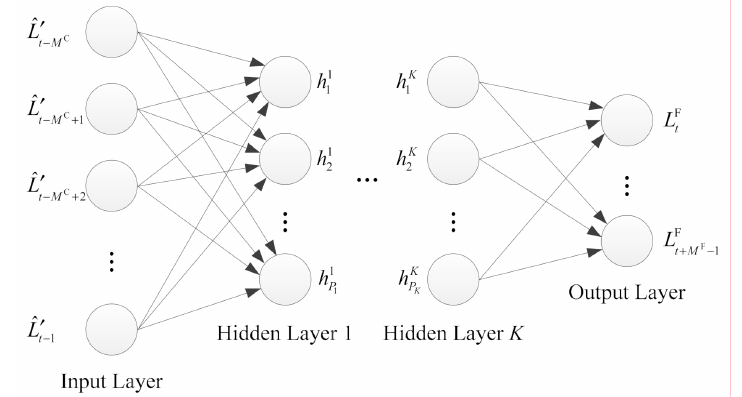
Figure 2. Load forecasting using multilayer feedforward neural